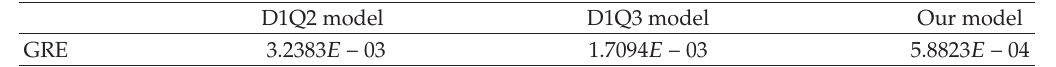
Table 5: Global relative errors with di ff erent